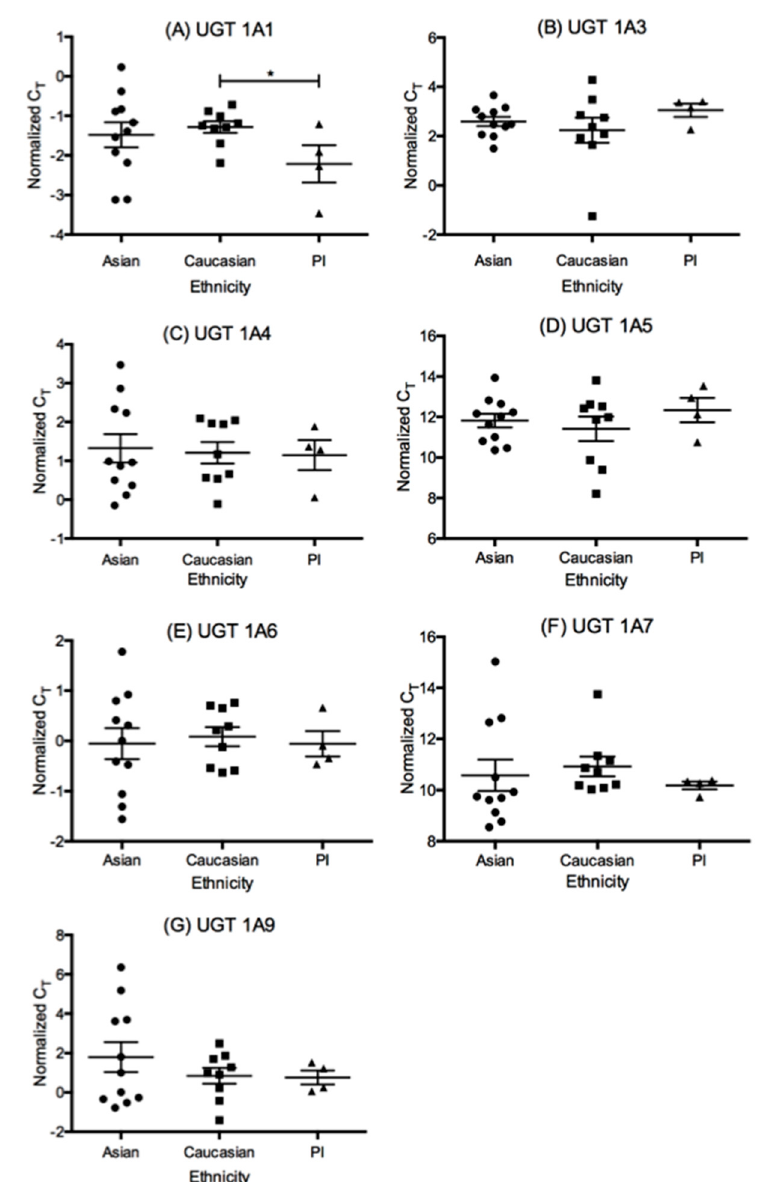
Figure 3. The quantitative PCR ∆∆ C T values in Asian (A, n = 11), Caucasian (C, n = 9), and Pacific Islander (PI, n = 4) ethnicities for all liver-specific UGT1A isoforms examined. Statistical significance is listed for p -values ≤ 0.05 (*) Note that higher ∆∆ C T means lower level of mRNA. ( A – G ) represent results for each individual UGT1A subfamily isoform.